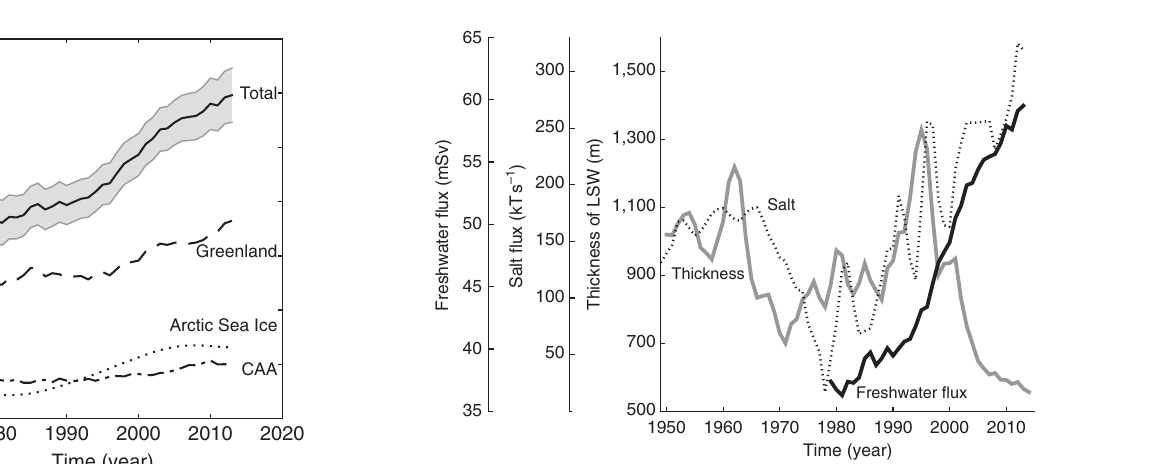
Figure 4 | Freshwater flux from Greenland and CAA and Arctic sea ice for the period 1979–2013. For Arctic sea ice, we plot only changes in flux (see text). The sum of these sources (Total) is also plotted. Grey shading indicates propagated uncertainty (see Supplementary Note 1).